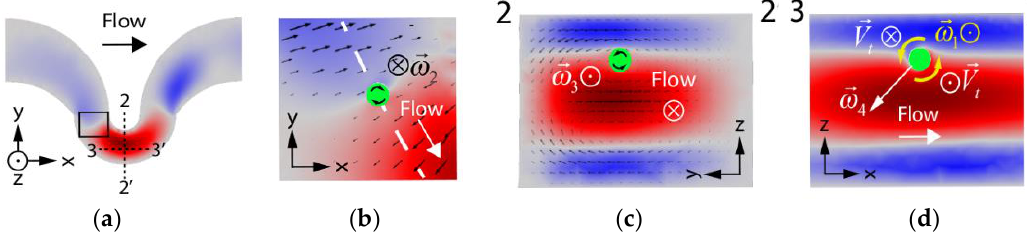
Figure 12. Simulated transverse velocity magnitude and sense of the flow in the x-y plane. Reddish regions correspond to an outward-moving flow (moving away from the center of curvature of the small curve) and vice versa for the bluish regions. ( a ) General view of the channel with marked cross sections; ( b ) Transverse flow field gradients in the x-y plane induce particle’s rotation, ω 2 ; ( c ) The flow around the particle in the center of the Dean vortex further induces a change in the particle’s rotation with a ω 3 component in the x direction; ( d ) The rotating particle causes a disturbance (yellow arrows) at the interface between the outward and inward lateral flows with V t components, which in turn causes a modification in the angular velocity of the particle yielding to the ω 4 component.